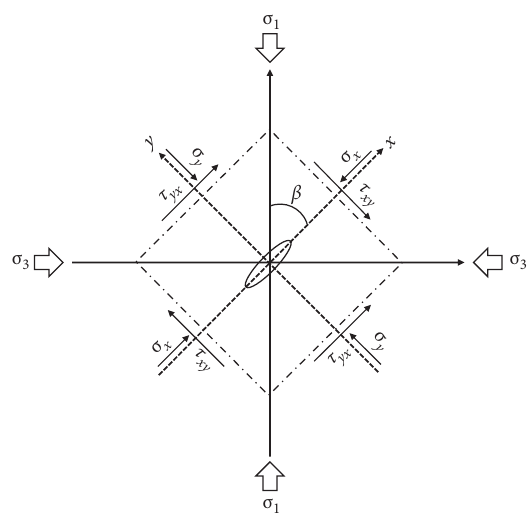
Figure 1: Force of microcracks in the